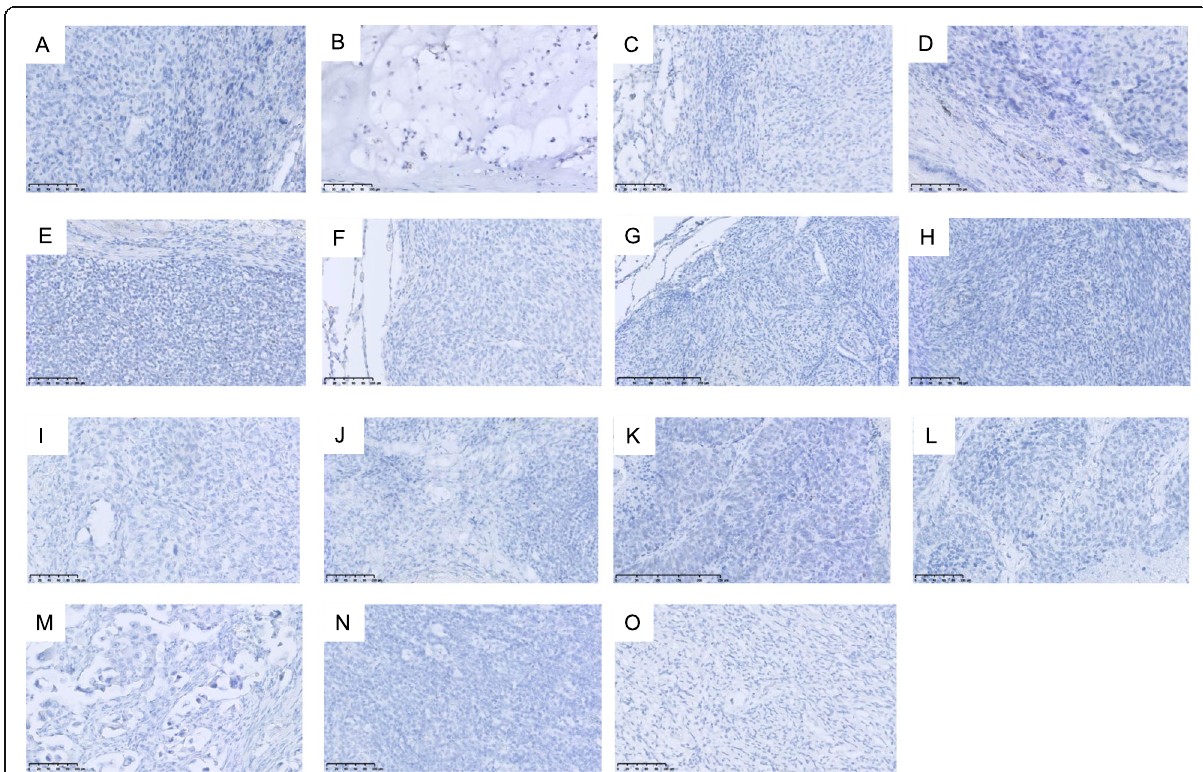
Fig. 4 Representative findings of immunostaining of SS18-SSX in other bone soft tissue sarcoma (× 200) (A) Osteosarcoma, (B) Chondrosarcoma, (C) Liposarcoma, (D) Malignant fibrous histiocytoma, (E) Ewing ’ s sarcoma, (F) Fibrosarcoma, (G) Leiomyosarcoma, (H) Undifferentiated spindle cell